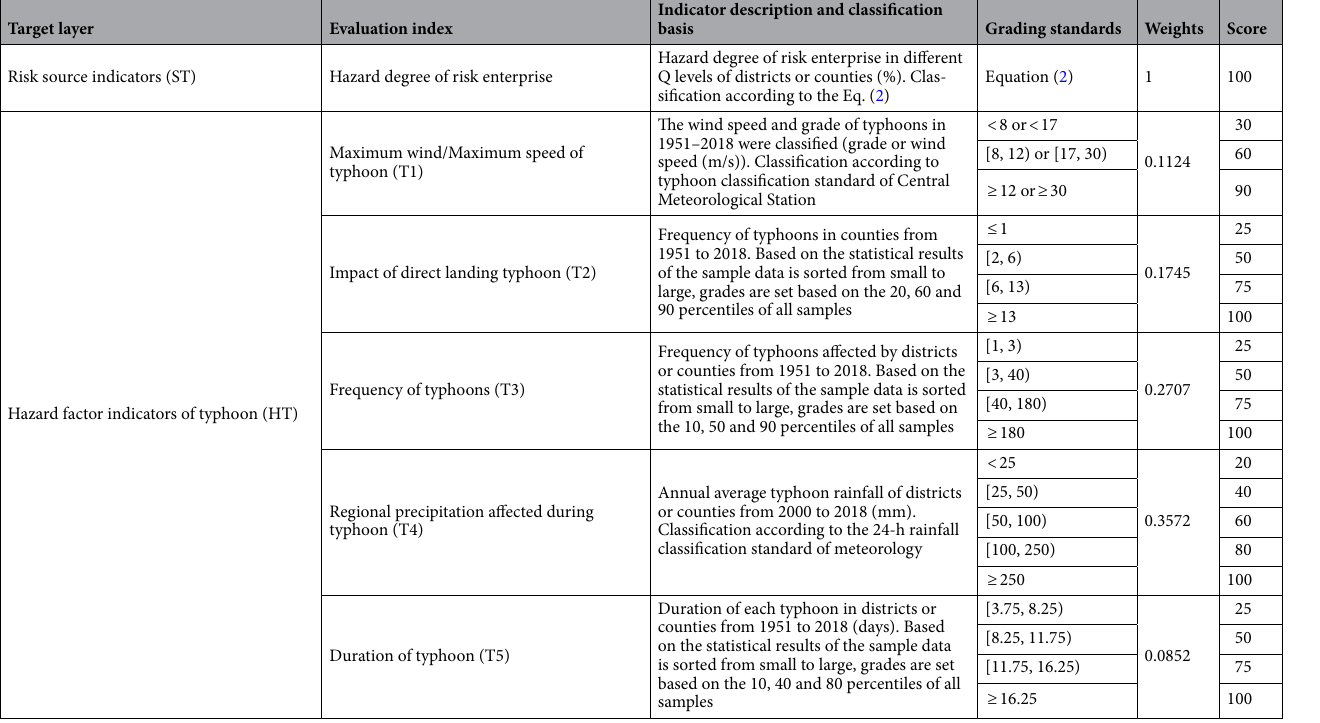
Table 3. The assessment system of Natech risk triggered by